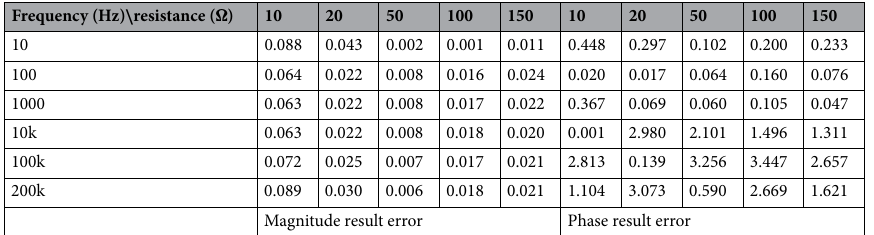
Frequency (Hz) \ resistance ( (cid:31)